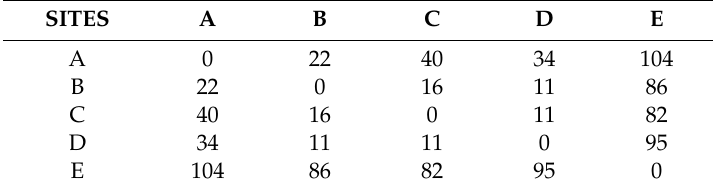
Table 1. Distance matrix among the five university campuses (sites) in kilometers (km).